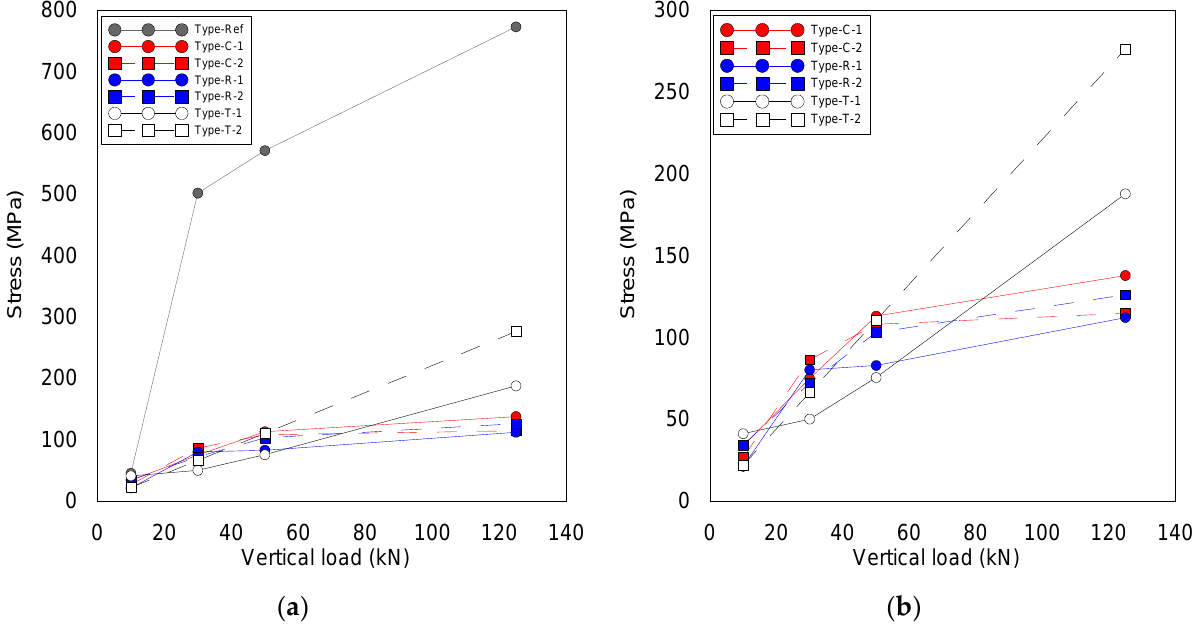
Figure 12. Maximum stress – vertical load relationships: ( a ) with Type-Ref; ( b ) without Type-Ref. For the C and R specimens, the stress on the ceramic friction material increases as the vertical load gets higher but the increment of the stress decreases. The effect of the sizes of modifications differs by less than 10% for the same load with relatively low magnitude of the absolute stress generated in the ceramic material and no noticeable overall ten- dency. For the T specimens, the stress generated in the ceramic friction material was rela- tively higher than in the C and R specimens. As shown in Figure 13, the averaged stresses are represented with the same type for each. The averaged stresses in the type of C and R represent under 5% of difference between them in every vertical load case, but the other averaged stress in the type of T increases almost linearly as the vertical load increases. In cases of under 50 kN of the vertical load, the difference of three types represents under 10%, but in the case of 125 kN, it represents about 50% compared to the other two types. This can be seen as having a high probability of exceeding the stress range allowed by the ceramic friction material when the external load is applied at a relatively large value. 0